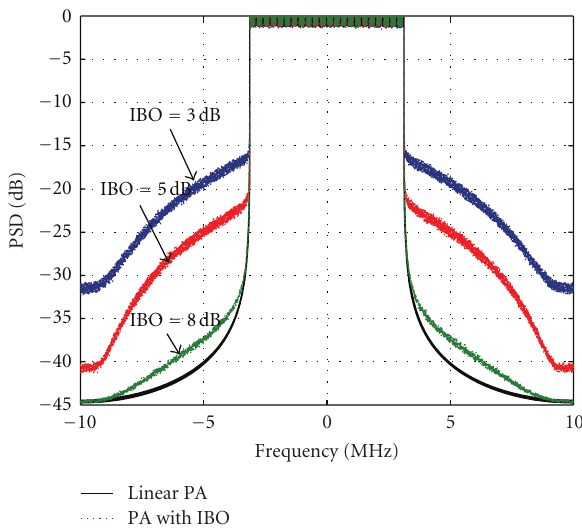
Figure 3: Power spectral density of an OFDM signal for di ff erent IBO values with N = 256, J = 4, h = 1, x SAT = 1, and γ = 10.